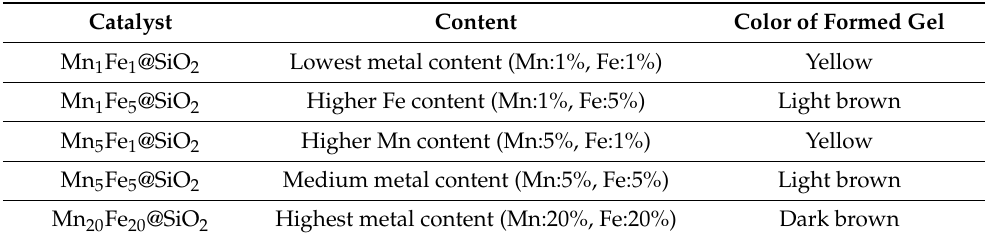
Table 1. The synthesized